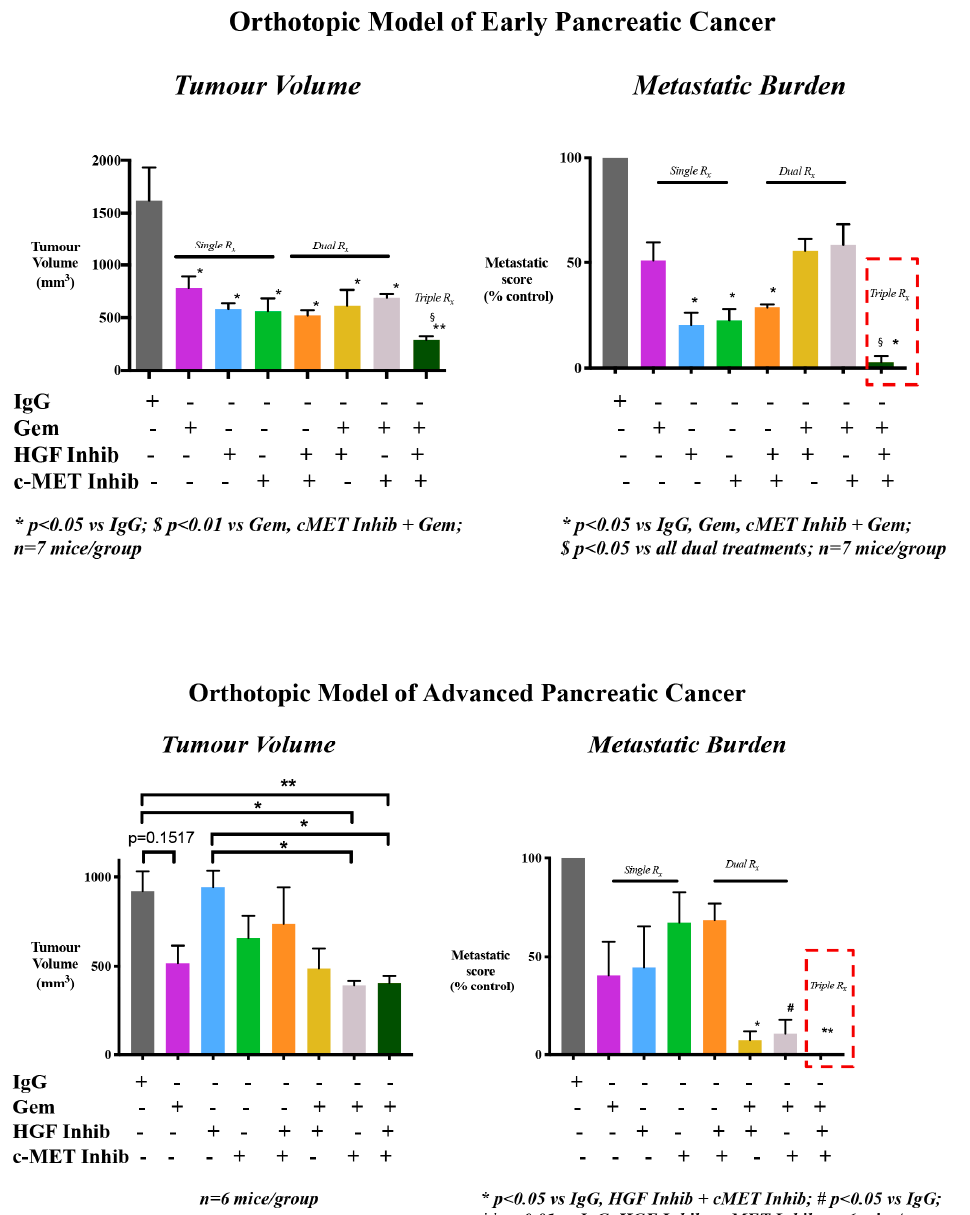
Figure 2. Effects of HGF/c-MET inhibition with and without gemcitabine on pancreatic cancer progression in orthotopic models of early and advanced pancreatic cancer. Pancreatic tumours were produced by injection of a mixture of human pancreatic cancer cells + human pancreatic stellate cells into the pancreas of Balb/c nude mice. For the early pancreatic cancer model, treatment was commenced one week after cell implantation, while for the advanced PC model treatment was commenced 4 weeks after cell implantation. In early pancreatic cancer, while single and dual combinations of the HGF neutralising antibody (HGF Inhib), c-MET inhibitor (cMET Inhib) and gemcitabine (Gem) reduced tumour volume compared to control (untreated) mice (IgG), the greatest reduction in tumour volume was observed in mice treated with the triple therapy. In advanced PC, the effects of single or dual agents on tumour volumes were variable, however, the greatest reduction in tumour volume was again observed in mice treated with triple therapy. Importantly, triple therapy had a striking effect on metastasis, with virtual elimination in early pancreatic cancer (only one liver nodule observed in one mouse) and complete absence of metastasis in advanced pancreatic cancer [10,53]).